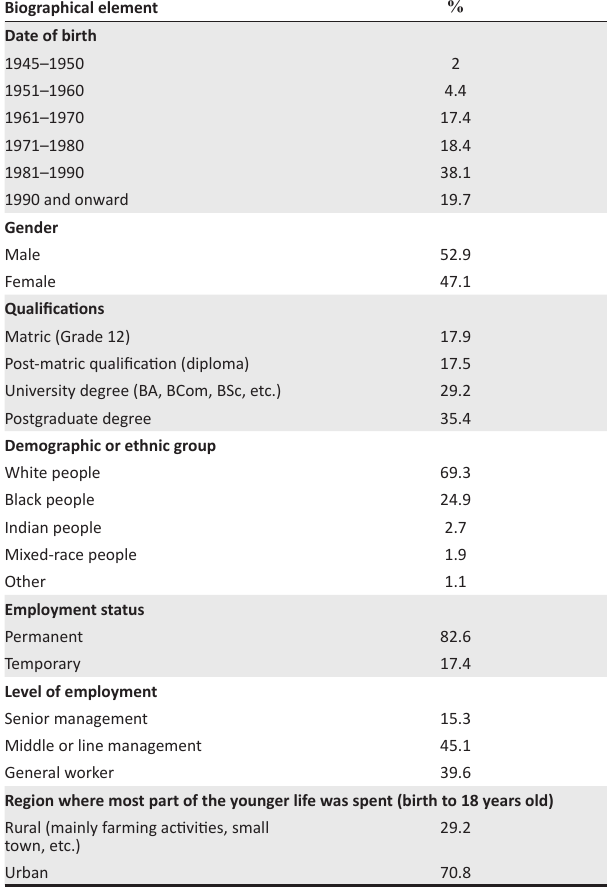
TABLE 1: Sample biographical and demographic